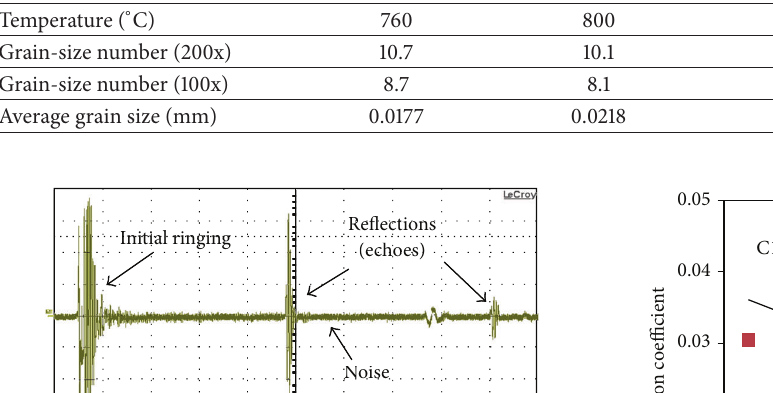
Table 2: Grain-size number and average grain size with different temperatures.